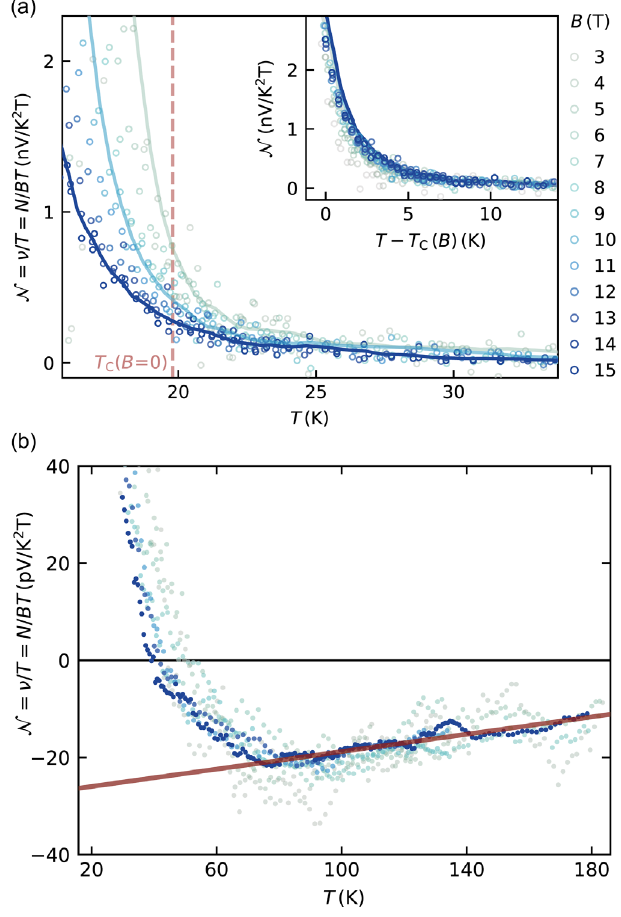
FIG. 3. Nernst effect above T c . (a) Temperature and magnetic- field normalized Nernst signal N close to T c (red dashed line). Open symbols show the raw data; lines are 10-point boxcar averages for 5 T, 10 T, and 15 T (gray to blue). Inset: same data rescaled with the field-dependent T c ð B Þ . (b) N at higher temper- atures, after 10-point boxcar averaging (note the reduced y scale). The red curve corresponds to the quasiparticle contribution − 2 . 7 μ S=T . H